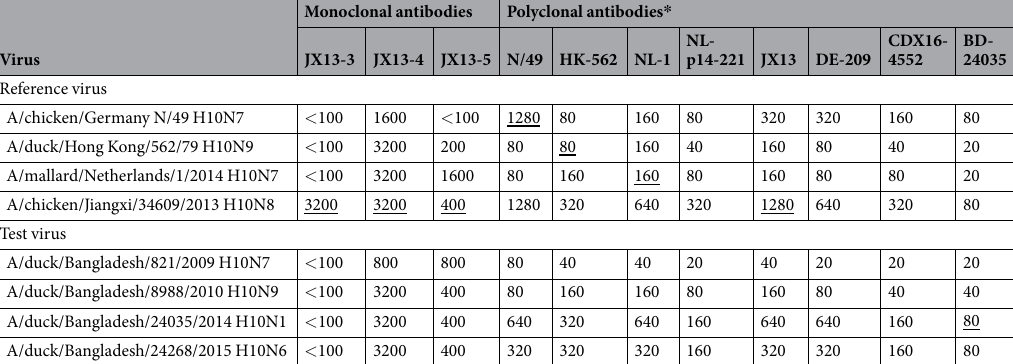
Table 2. Antigenic characterization by the hemagglutination inhibition assay of H10 AIVs isolated from LPMs in Bangladesh. * Polyclonal antibodies were produced in the ferret. Homologous titers are underlined.